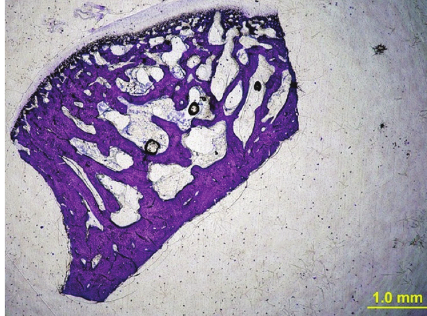
Figure 4: A 50 𝜇 m thick histologic section prepared for histomor- phometric analysis from control group (toluidine blue stain, original magnification × 2).